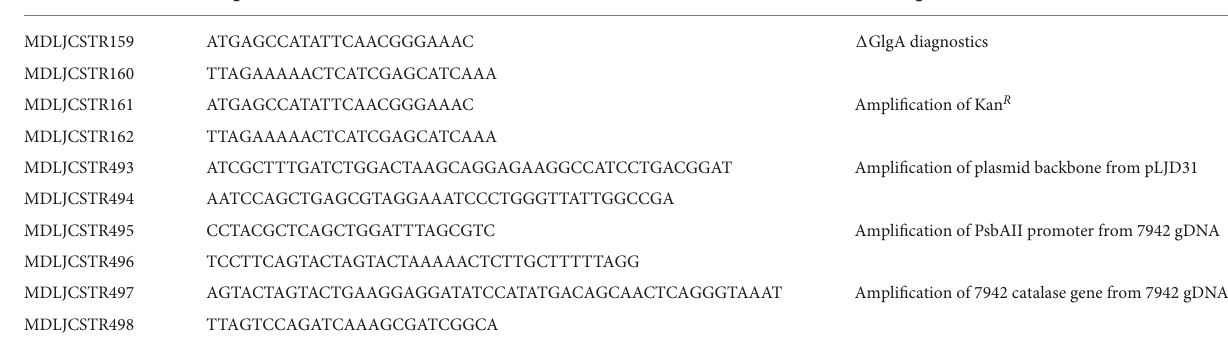
TABLE 2 Oligonucleotides used in the